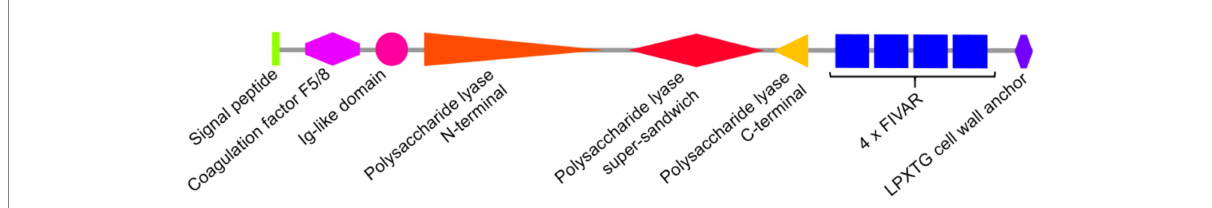
FIGURE 6 HylA protein of Enterococcus faecalis . The HylA protein is composed of a N-terminal signal peptide, a coagulation factor F5/8 domain (F5_F8_ type_C PF00754), an Ig-like domain (Big_2 PF02368), enzymatic family 8 polysaccharide lyase domains (Lyase_8_N PF08124, Lyase_8 PF02278, and Lyase_8_C PF02884.17), a repetition of four FIVAR domains (Found In Various Architectures PF07554), and a LPXTG cell-wall anchor domain (Gram_pos_anchor PF00746). The C-terminal transmembrane and intracytoplasmic domains are not shown. The short version of Lyase_8 is solely constituted of lyase